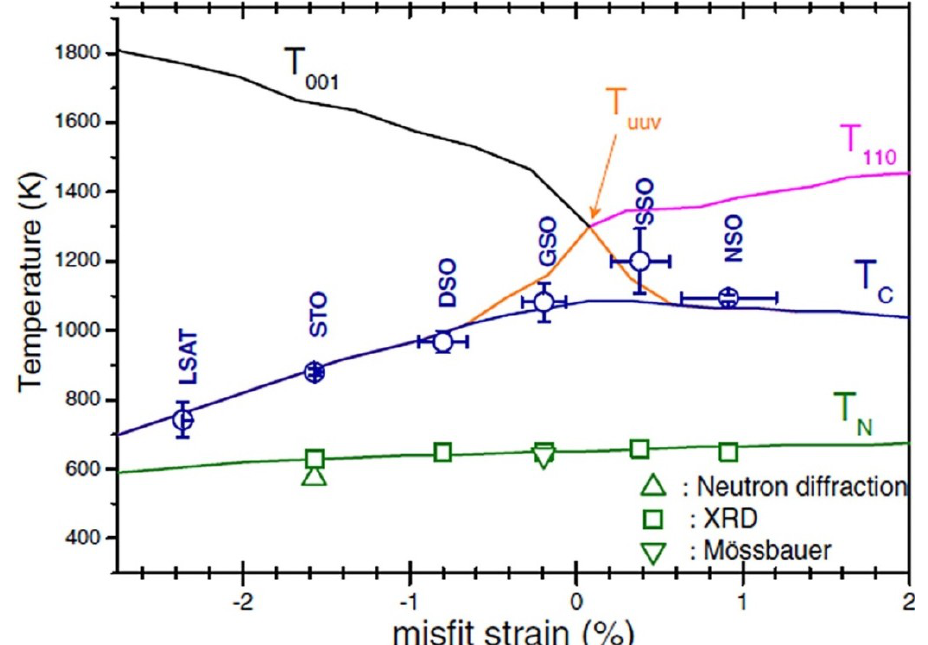
Figure 9. Transition temperature of BFO film as a function of misfit strain: theoretical T (blue line) and T (green line); experimental T (circles) and T (squares and triangles) c N c N values; the activation temperatures for the antiferrodistortive oxygen tilting along z direction (tetragonal distortion T , black line), x - y plane (orthorhombic one T , 001 110 red line), and for the tilting along [uuv] direction (monoclinic distortion T , orange line) uuv are plotted. (Reprinted with permission from [29]. Copyright 2010 American Physical